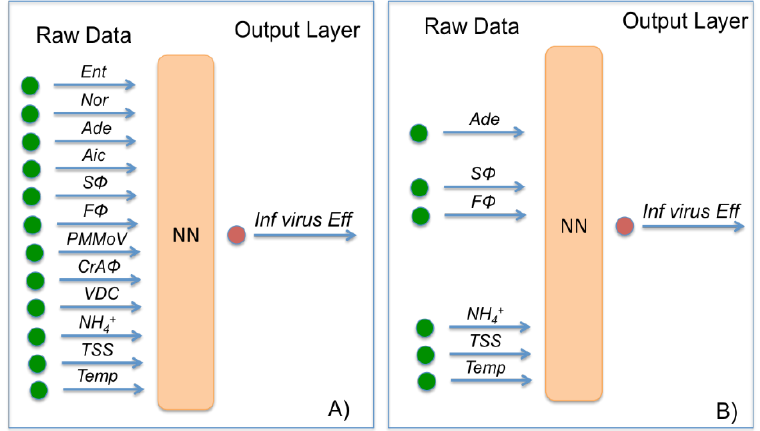
Figure 3. Illustration of ANN structure change based on sensitivity analysis of input variables. ( A ) Illustrate the initial scenario that includes all surrogates and parameters, ( B ) Illustrate the removal of a subset of input variables based on the sensitivity analysis.